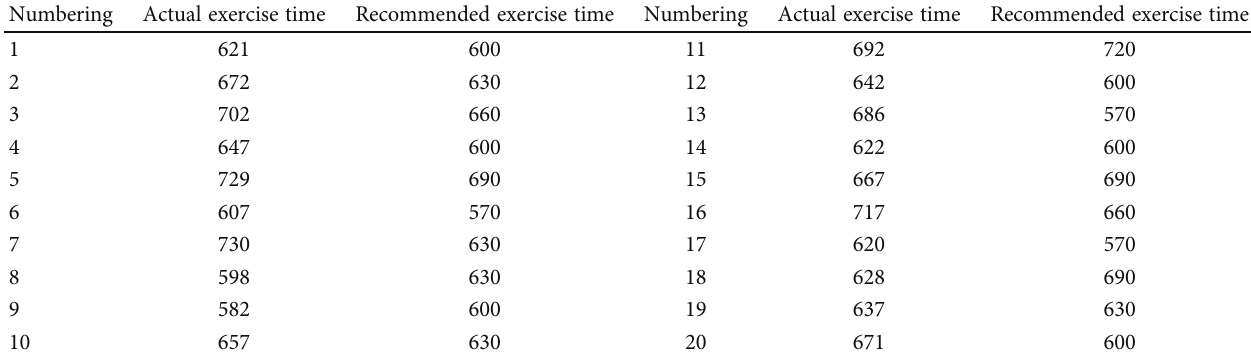
Table 5: Actual exercise time and recommended exercise time for athletes.